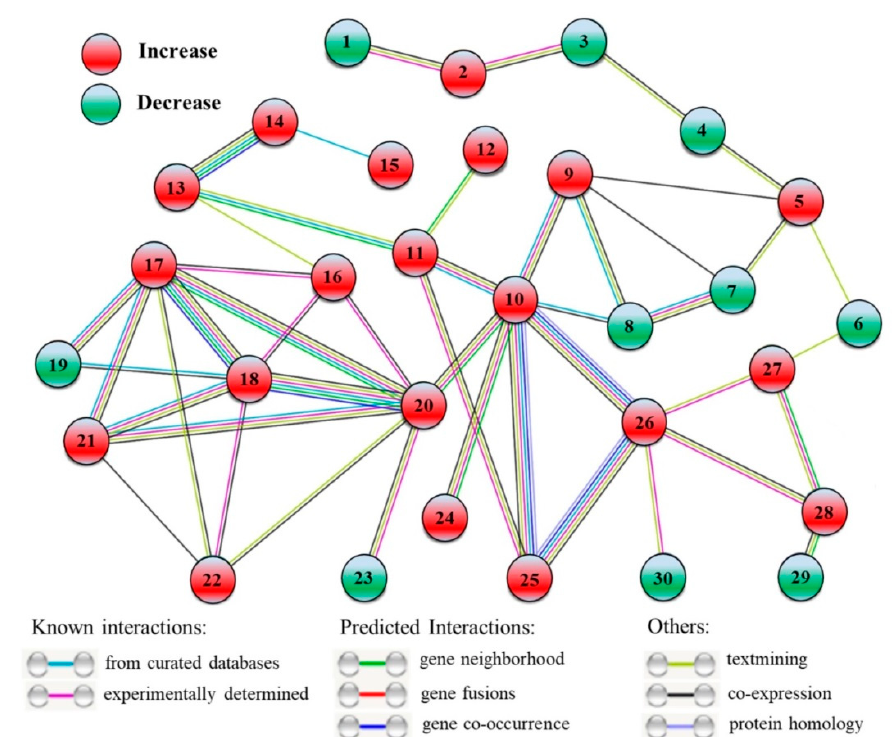
Figure 9. Interaction network of the identified differentially expressed proteins (DEPs) when HSG compared to HS (HSG vs. HS). This network shows only known and direct interactions among identified DEPs. C, control (normal condition); HS, heat stress; HSG, heat-stressed plants pretreated with γ -aminobutyric acid (GABA). 1, RPA2; 2, SWI2; 3, CHB3; 4, EMB140; 5, C2H2 ZNF; 6, AGO1; 7, SFU2af-A; 8, SFU2af-B; 9, BCLP; 10, HSP70b; 11, PFK5; 12, ASN2; 13, FK2; 14, BFRUCT; 15, RFS2; 16, RGG; 17, 40SRP-S3; 18, 40SRP-S14; 19, ETIF5; 20, 60SRP-L4; 21, 60SRP-L28; 22, BTF3; 23, Tim44; 24, HSP16.9; 25, HSP90; 26, HSP70-2; 27, Cu/ZnSOD; 28, APX4; 29, ETFBETA; 30, DNL-type ZFP.